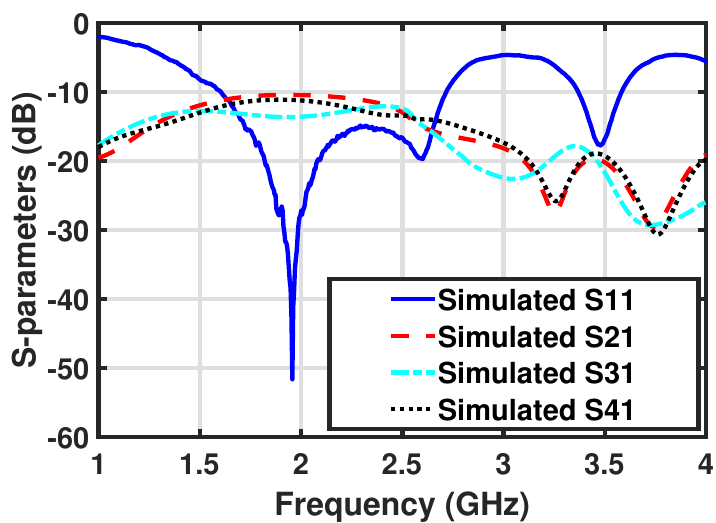
Figure 4. S-parameters for antenna 1 of the optimized dual-band MIMO antenna.